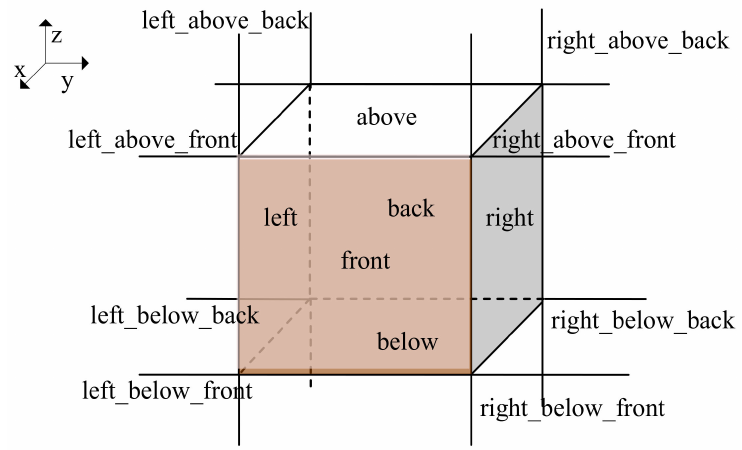
Figure 7. Directional